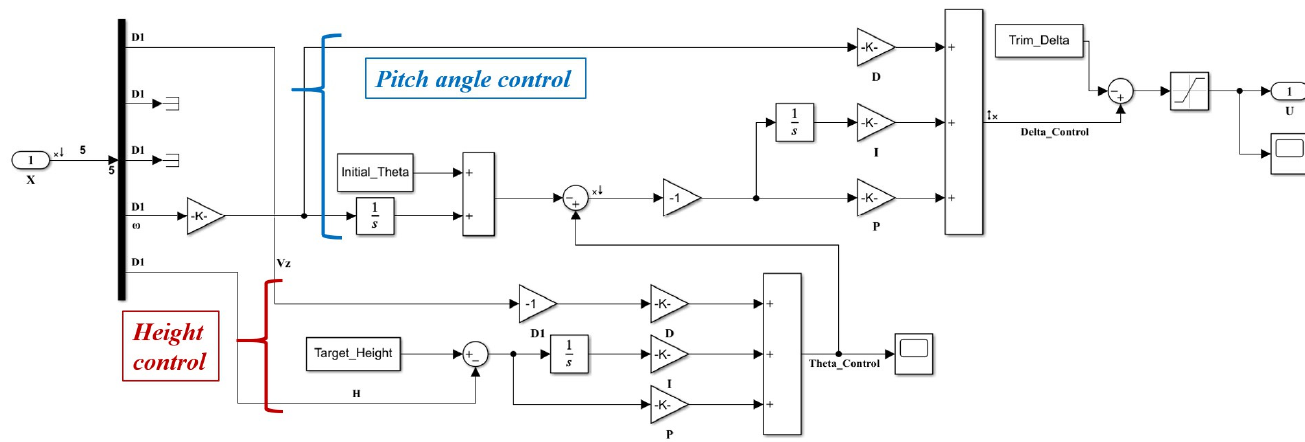
Figure 20. The longitudinal control law.